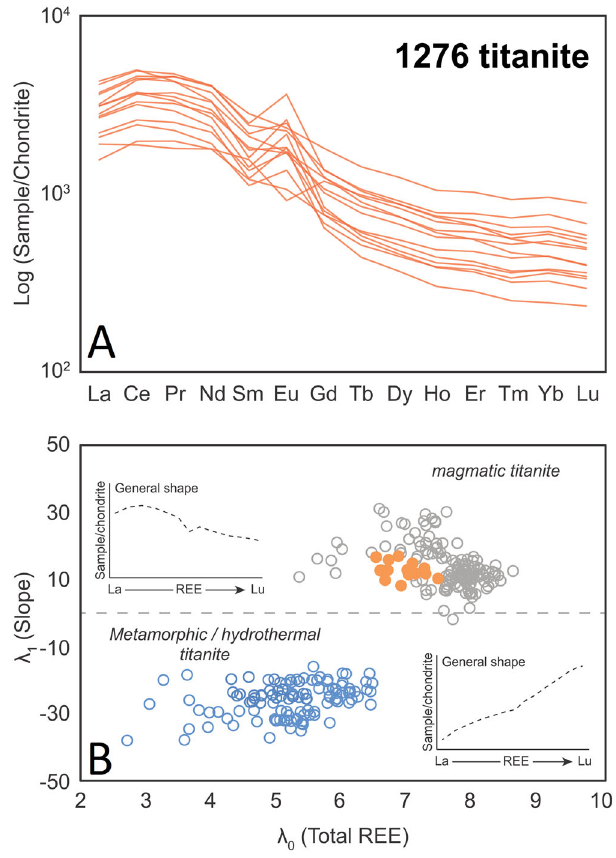
Fig. 8 Titanite trace element geochemistry. A Titanite chondrite- normalized REE patterns from sample 1276 using reference values from ref. 70 ; B Comparison between sample 1276 titanite ( fi lled orange circles) and typical magmatic (gray un fi lled circles) and metamorphic titanite (blue un fi lled circles) compiled from the literature 27 . The reader is referred to ref. 71 for information about the lambda ( λ n) parameters, which were calculated using BLambdaR 72 .